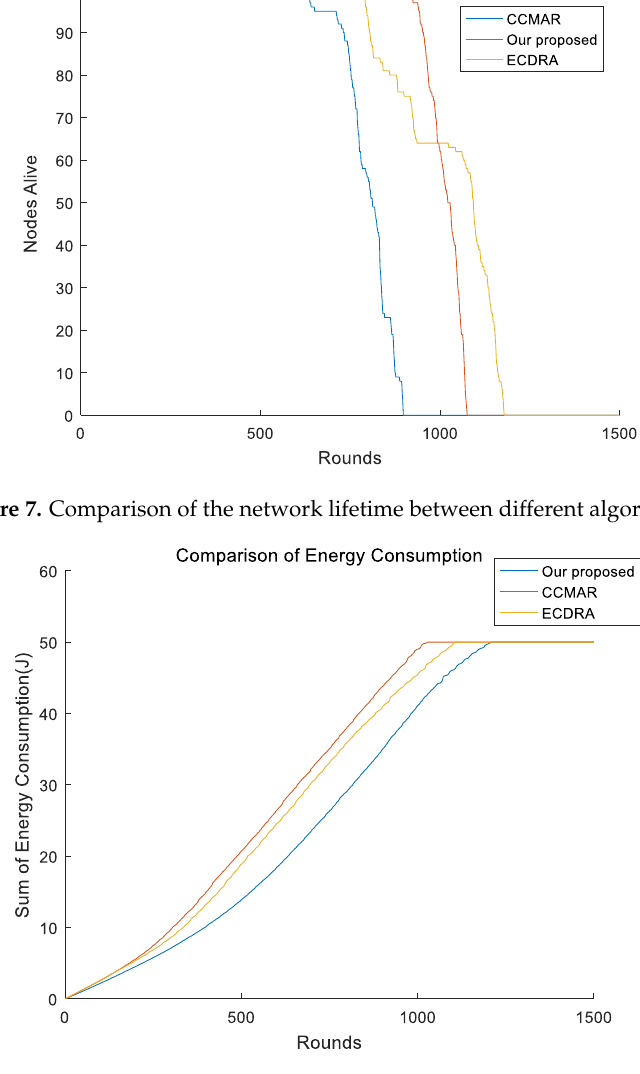
Figure 8. Comparison of total energy consumption between different algorithms.